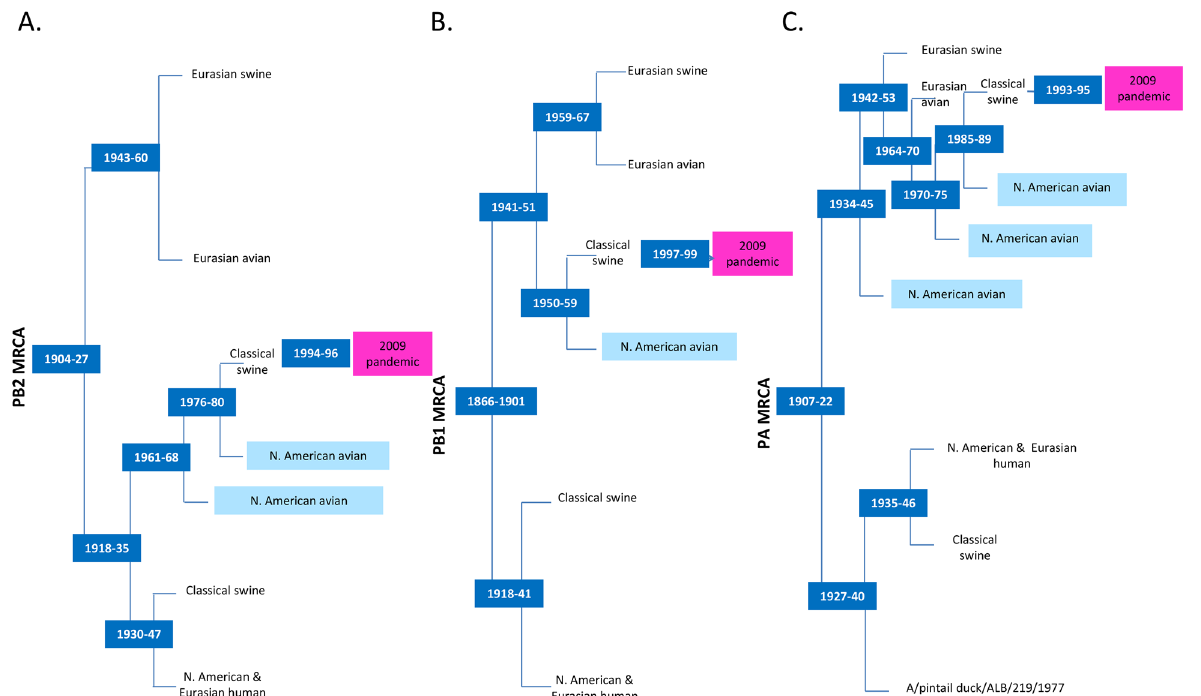
Fig 2. Schematic of the evolutionary history among PB2, PB1 and PA segments of H1N1 IAVs. The schematic view is based on the phylogenetic trees of avian, swine, and human origin H1N1 IAVs and the most recent common ancestor (MRCA) for (A) PB2 gene segments, (B) PB1 gene segments, and (C) PA gene segments. North American avian (light blue) and 2009 pandemic H1N1 viruses (pink) are highlighted.